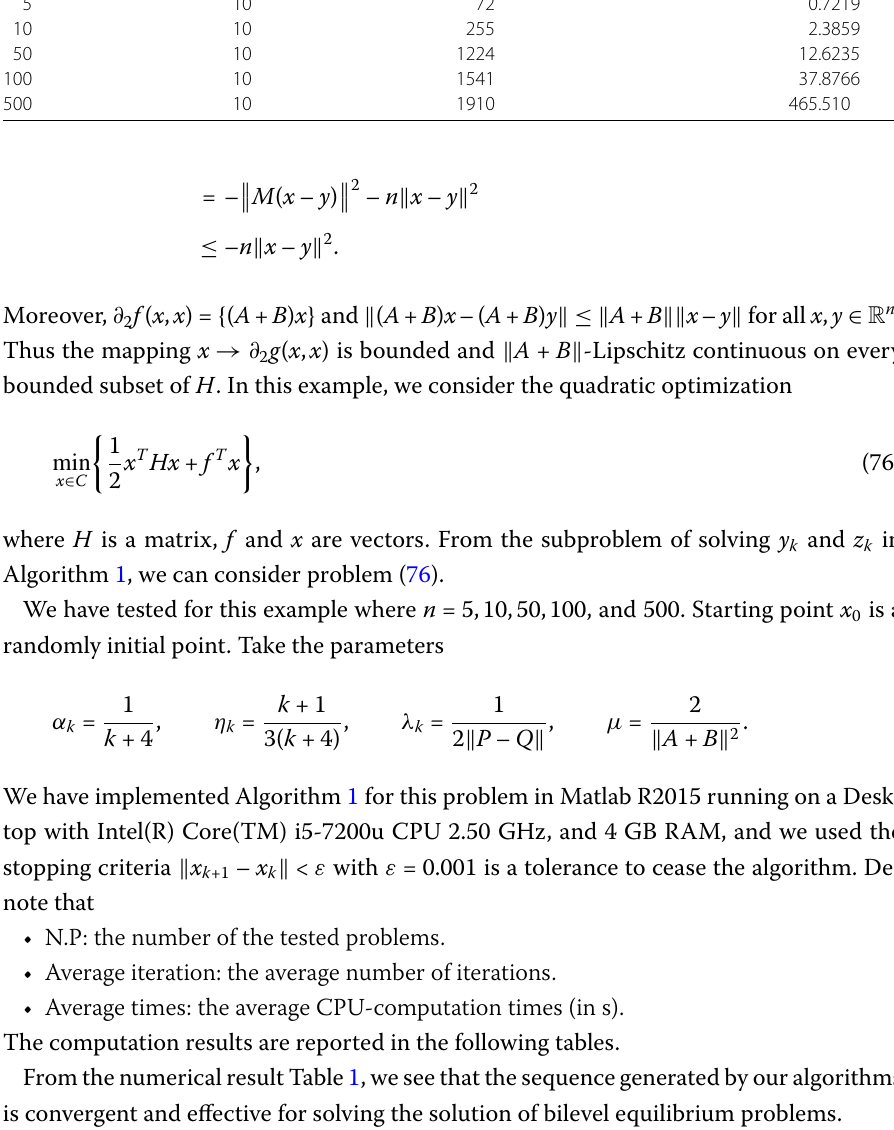
Table 1 The results computed on Algorithm 1 n